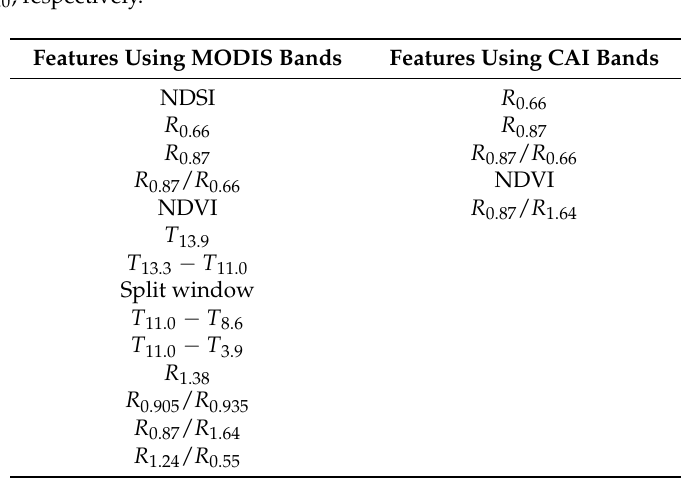
Table 3. Features using MODIS bands and CAI bands. R wavelength and T wavelength denote the top of atmosphere (TOA) reflectance and brightness temperature, respectively, at a wavelength. The definitions of NDSI, NDVI, and Split window are ( R 0.66 − R 1.64 )/( R 0.66 + R 1.64 ), ( R 0.87 − R 0.66 )/( R 0.87 + R 0.66 ), and T 11.0 − T 12.0 ,